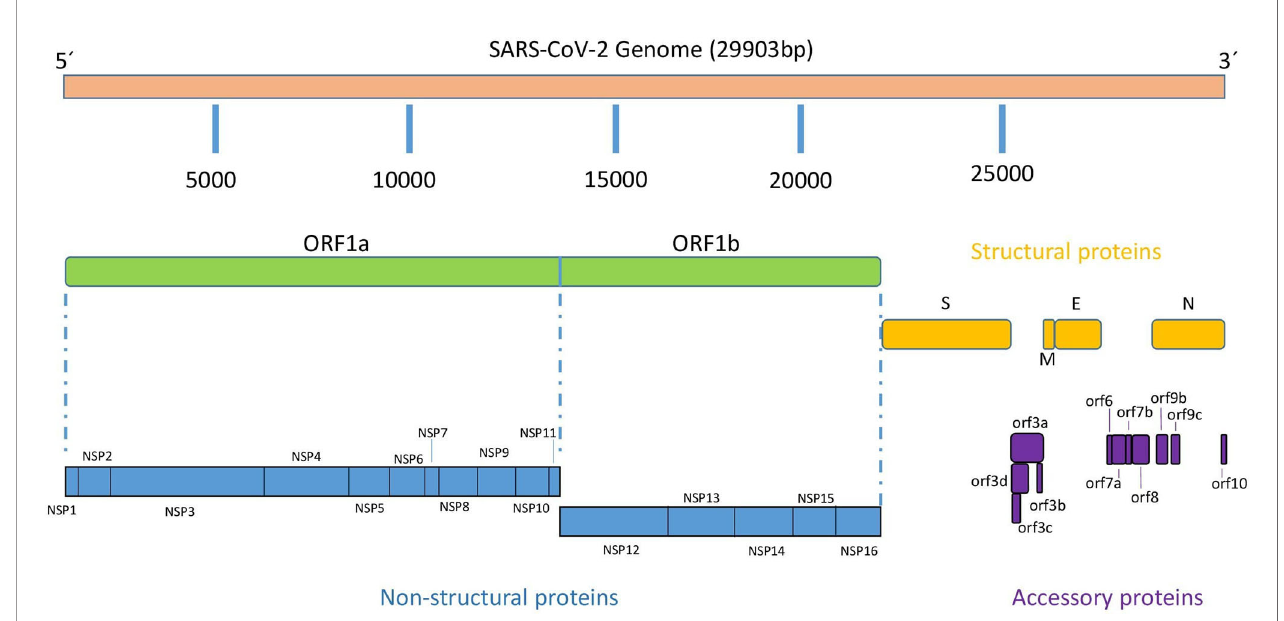
FIGURE 1 | SARS-CoV-2 genomic